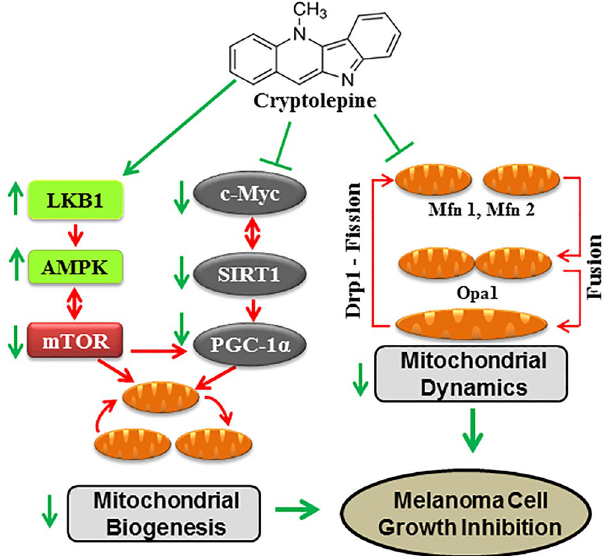
Figure 8. Schematic diagram showing the effects of cryptolepine on mitochondrial dynamics, biogenesis and the regulatory cascade of events resulting in suppression of melanoma cell growth. The process of melanomagenesis is influenced by dysregulated mitochondrial dynamics and mitochondrial biogenesis associated with dysregulation of regulatory molecules. The dysregulated events in melanoma cells are shown with red arrows, the therapeutic effects of cryptolepine, which result in inhibition of melanoma cell growth, are shown with green